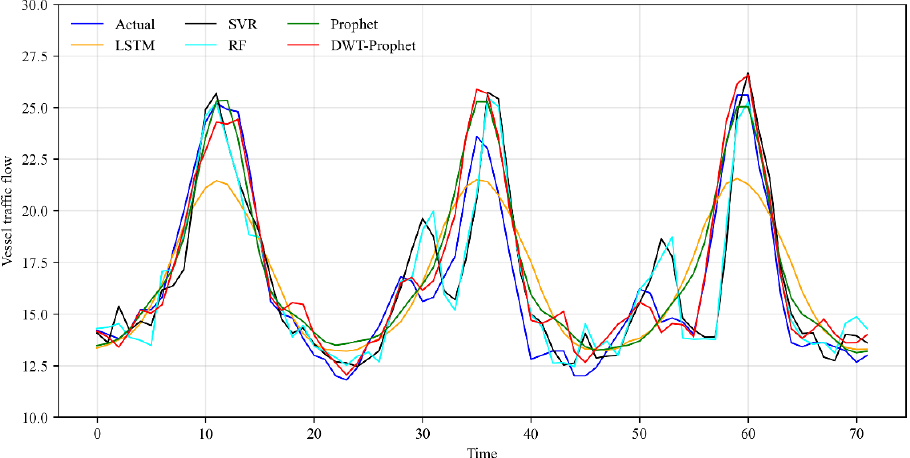
Figure 9. Comparison of the actual and predicted results of the four components of the test set: ( a ) A 3 ; ( b ) D 3 ; ( c ) D 2 ; ( d ) D 1 .